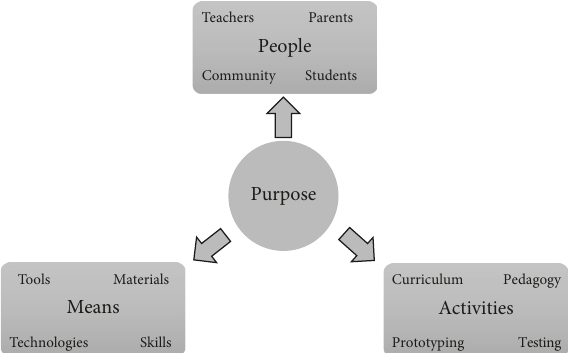
Figure 1: Representation of the proposed people, means, and activities framework for educational Makerspaces.